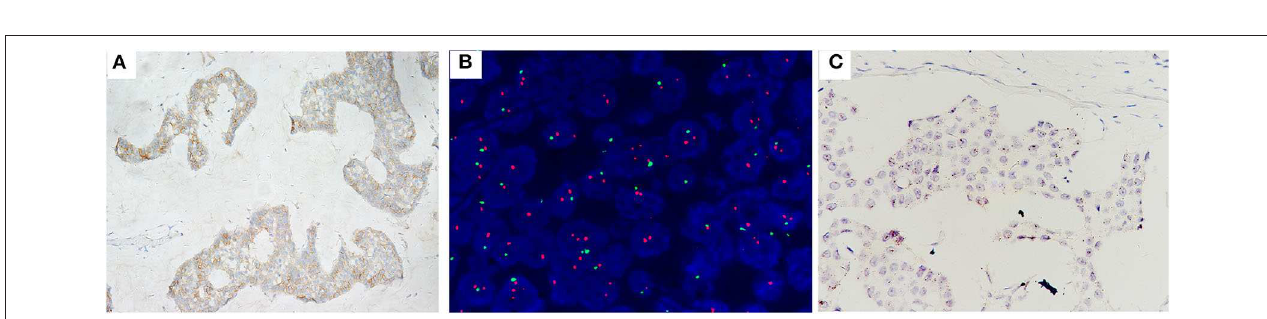
FIGURE 4 | Case no. 30, with IHC2 + (A) , the highest HER2/CEP17 ratio of 3.90, the lowest average CEP17 copy number/cell of 1.00, and average HER2 signals/cell of 3.90 (B) . Showed the lowest level of HER2 mRNA expression (score 1 by RNAscope) (C) .